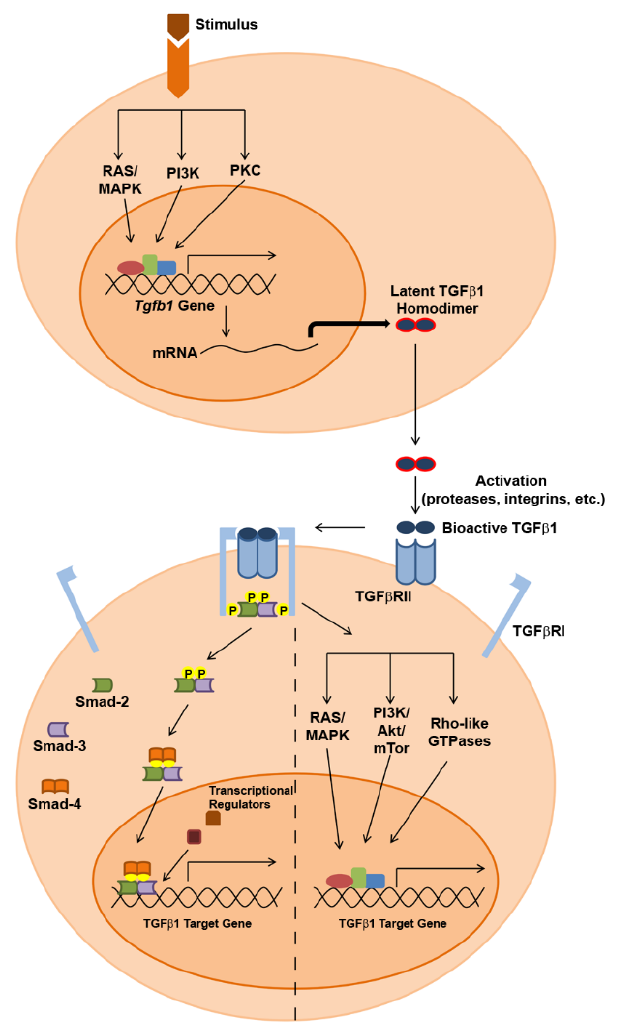
Figure 1. Summary of TGF β 1 expression and SMAD ‐ dependent/SMAD ‐ independent signaling Summary of TGF β 1 expression and SMAD-dependent/SMAD-independent pathways. signaling